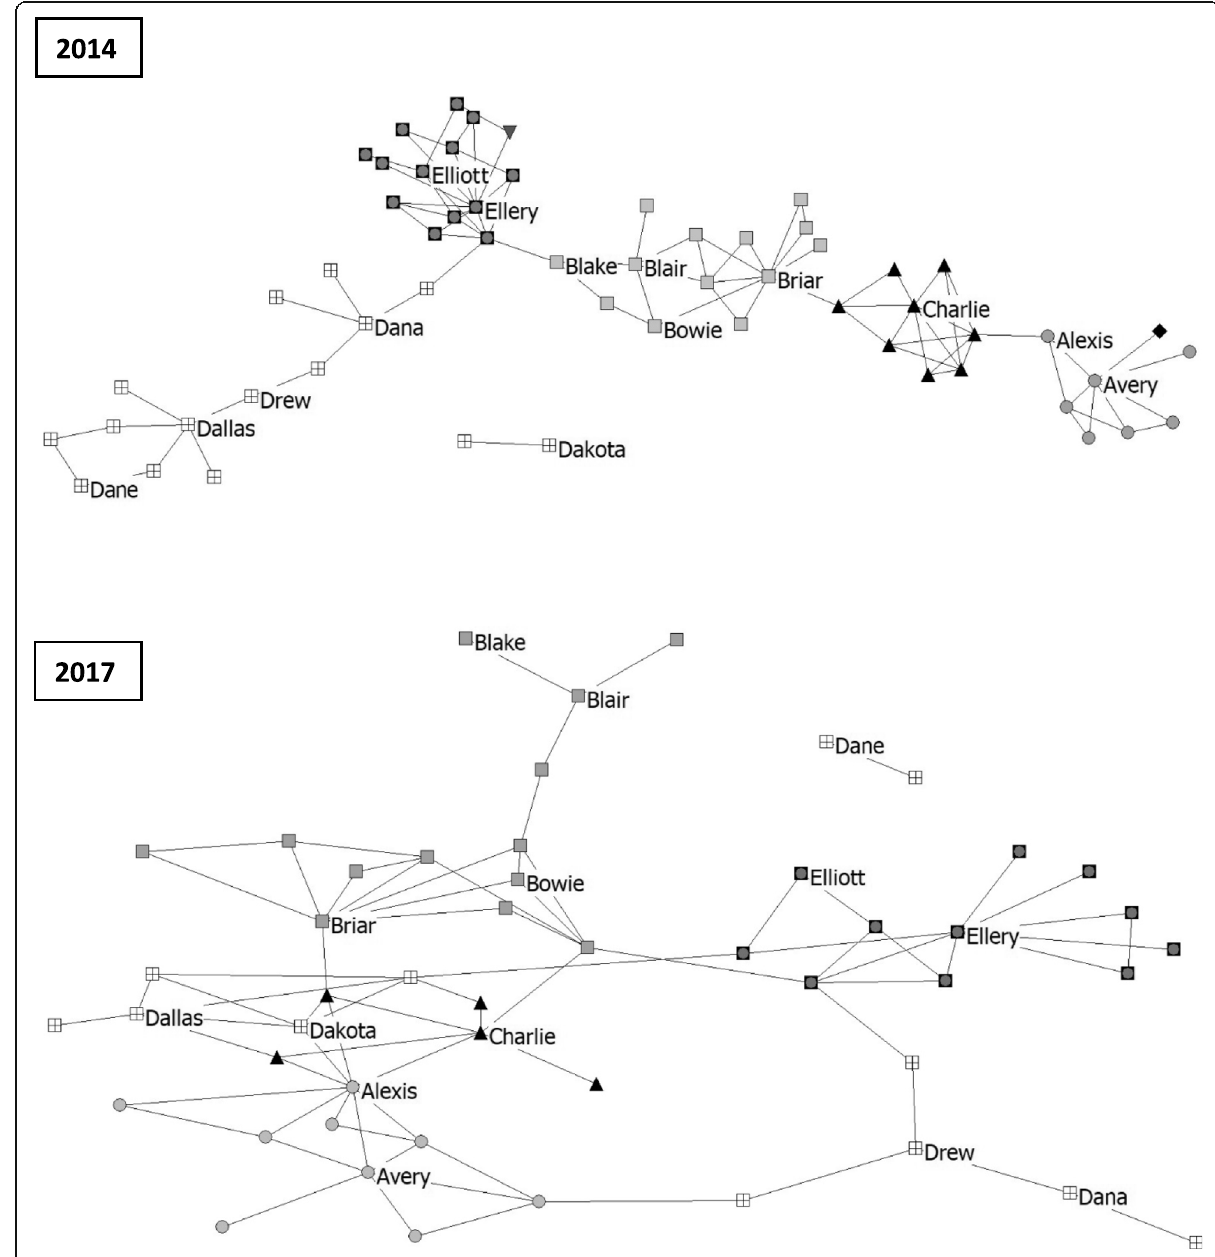
Fig. 4 The networks of teaching-related conversations amongst faculty using data from the 2014 (top) and 2017 (bottom) surveys. Symbols represent the fourteen participants in this study and participants not in this study but who were identified as part of the network of teaching- related conversations. Lines represent ties between faculty, meaning they connect faculty wherein one or both reported engaging in teaching- related conversations. Symbol shapes and colors represent different units in the institution of higher